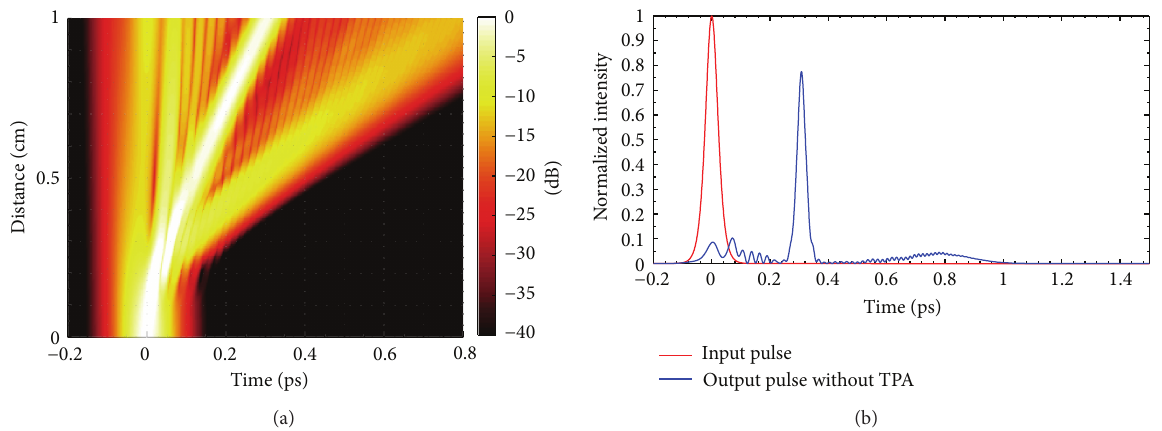
Figure 8: (a) Temporal evolution for the 1cm long silicon waveguide without considering the effect of TPA. (b) Contrast of the input pulse and output pulse without considering the effect of TPA. The input soliton is 50 fs (FWHM), 25 W peak power hyperbolic secant soliton with order 𝑁 = 3 .